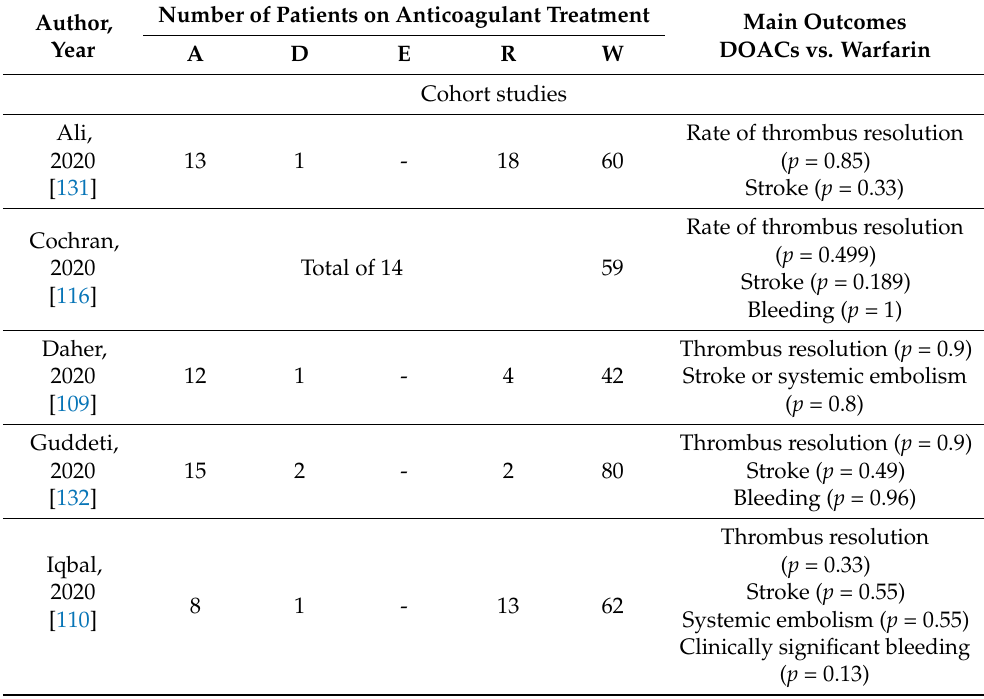
Table 5. Major studies assessing the efficacy and safety of DOACs in patients with LV